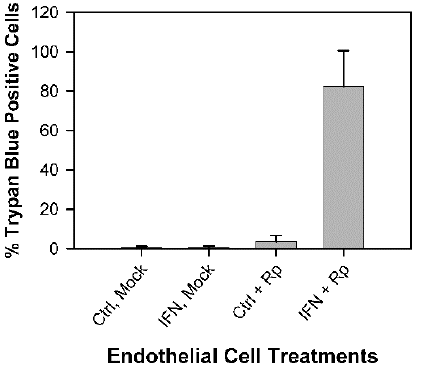
Figure 1. IFN- γ -pretreated cultures of C166 endothelial cells showed increased permeability to trypan blue dye within 4 h after addition of R. prowazekii . Data were collected in twelve independent experiments. Each bar represents the mean ± standard deviation (SD) for the following numbers of determinations: untreated mock-infected cultures (Ctrl, Mock), n = 19; IFN- γ -pretreated mock-infected cultures (IFN, Mock), n = 21; untreated R. prowazekii -infected cultures (Ctrl + Rp), n = 24; IFN- γ -pretreated R. prowazekii -infected cultures (IFN + Rp), n = 26. The IFN- γ -pretreated infected cultures differed significantly from the other cultures ( p < 0.01). At 1 h after addition of the rickettsiae, the percentages of cells infected were 94.9 ± 6.1 and 96.4 ± 6.3, and the numbers of rickettsiae per infected cell were 13.6 ± 4.8 and 15.9 ± 6.4 in the untreated and IFN- γ -pretreated cultures, respectively (mean ± SD, n = 16) (Table